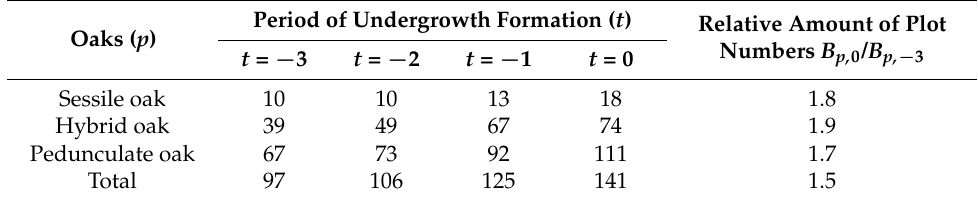
Table 3. Dependence of occupied number of plots ( B p,t ) of oak trees in the undergrowth by the formation period ( t ) in years (Equation (5)). Period of Undergrowth Formation ( t ) Oaks ( p )